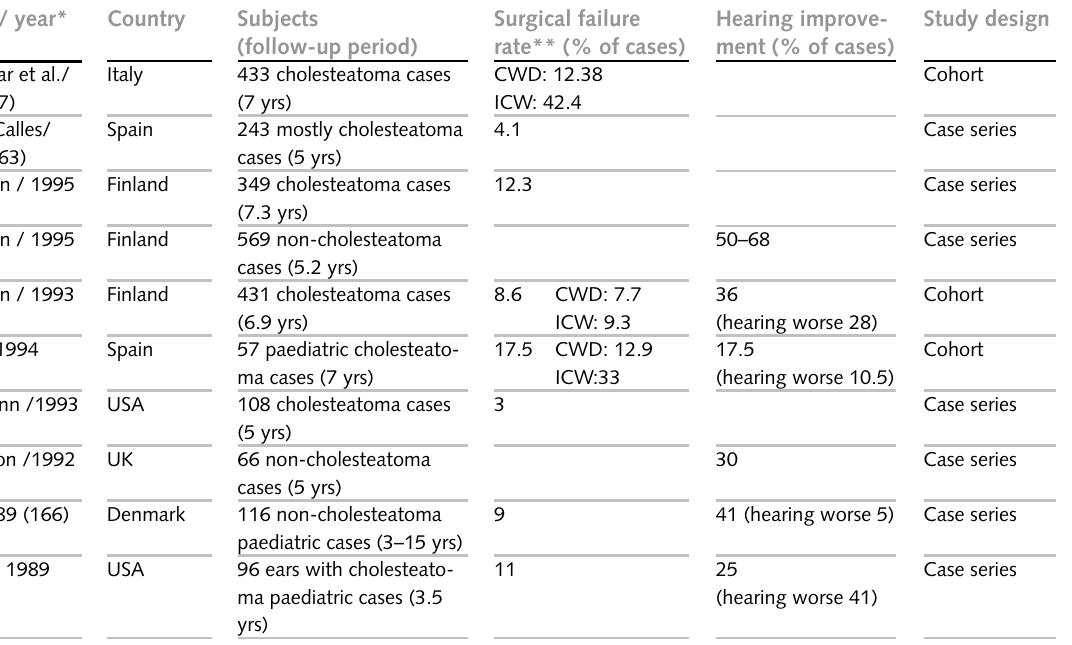
Table 12. Results of mastoidectomy for